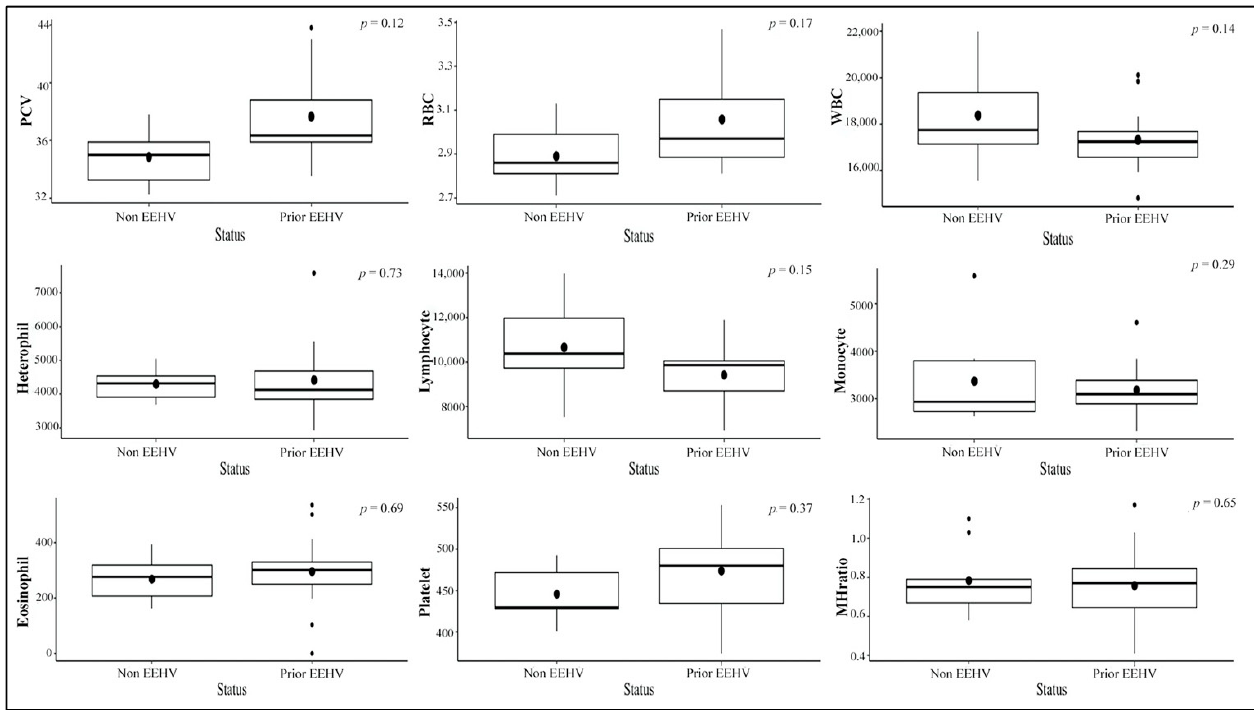
Figure 2. Boxplots of hematology values according to EEHV status (non-EEHV or prior-EEHV), excluding E5 that developed EEHV-HD and died during the study.